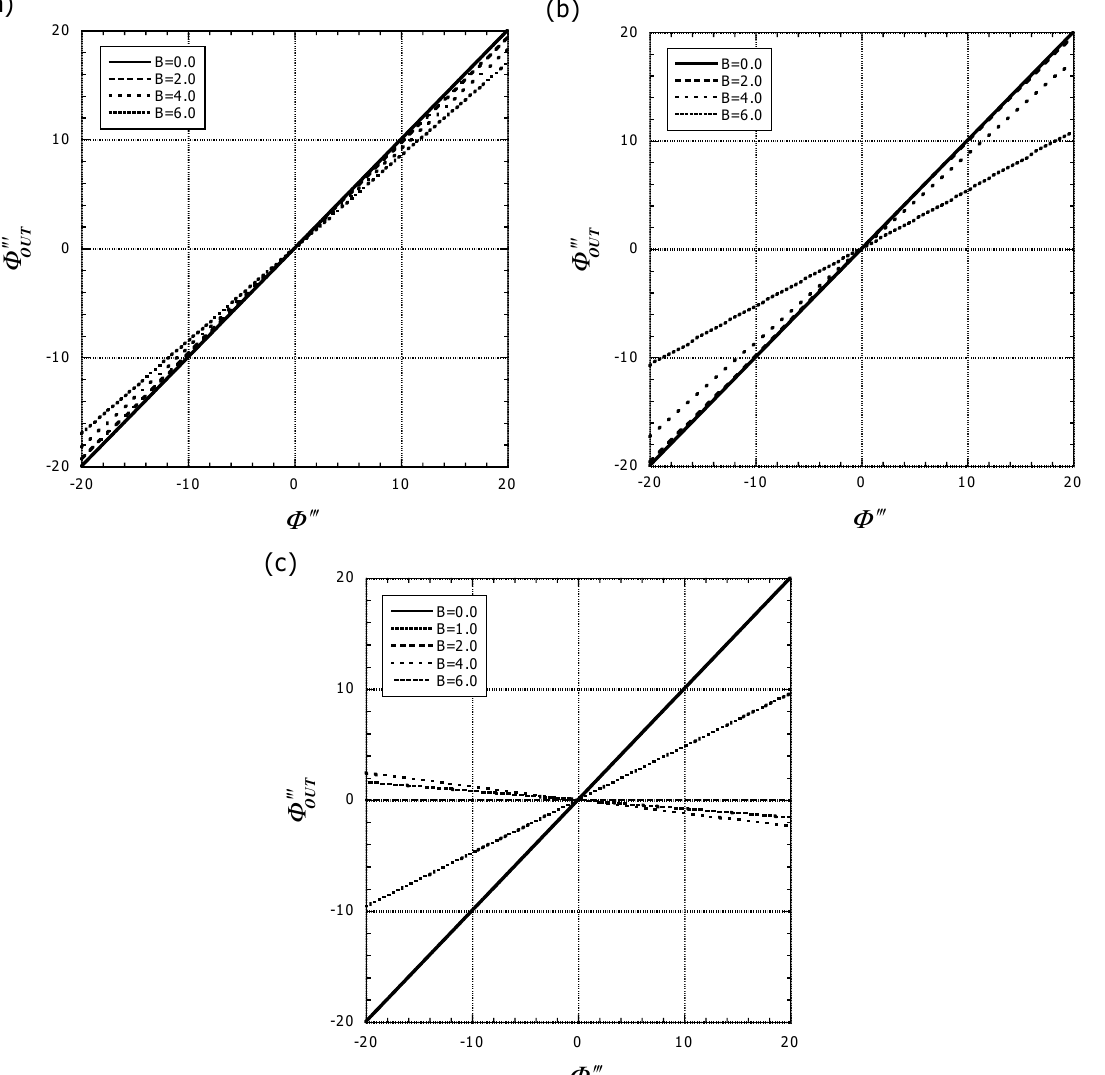
Figure 2. Third-Order Dispersion (TOD) of the output pulse Φ TOD ′′′Φ for various values of B and initial GDD ′′Φ of (a) 10, (b) − 10, and (c)